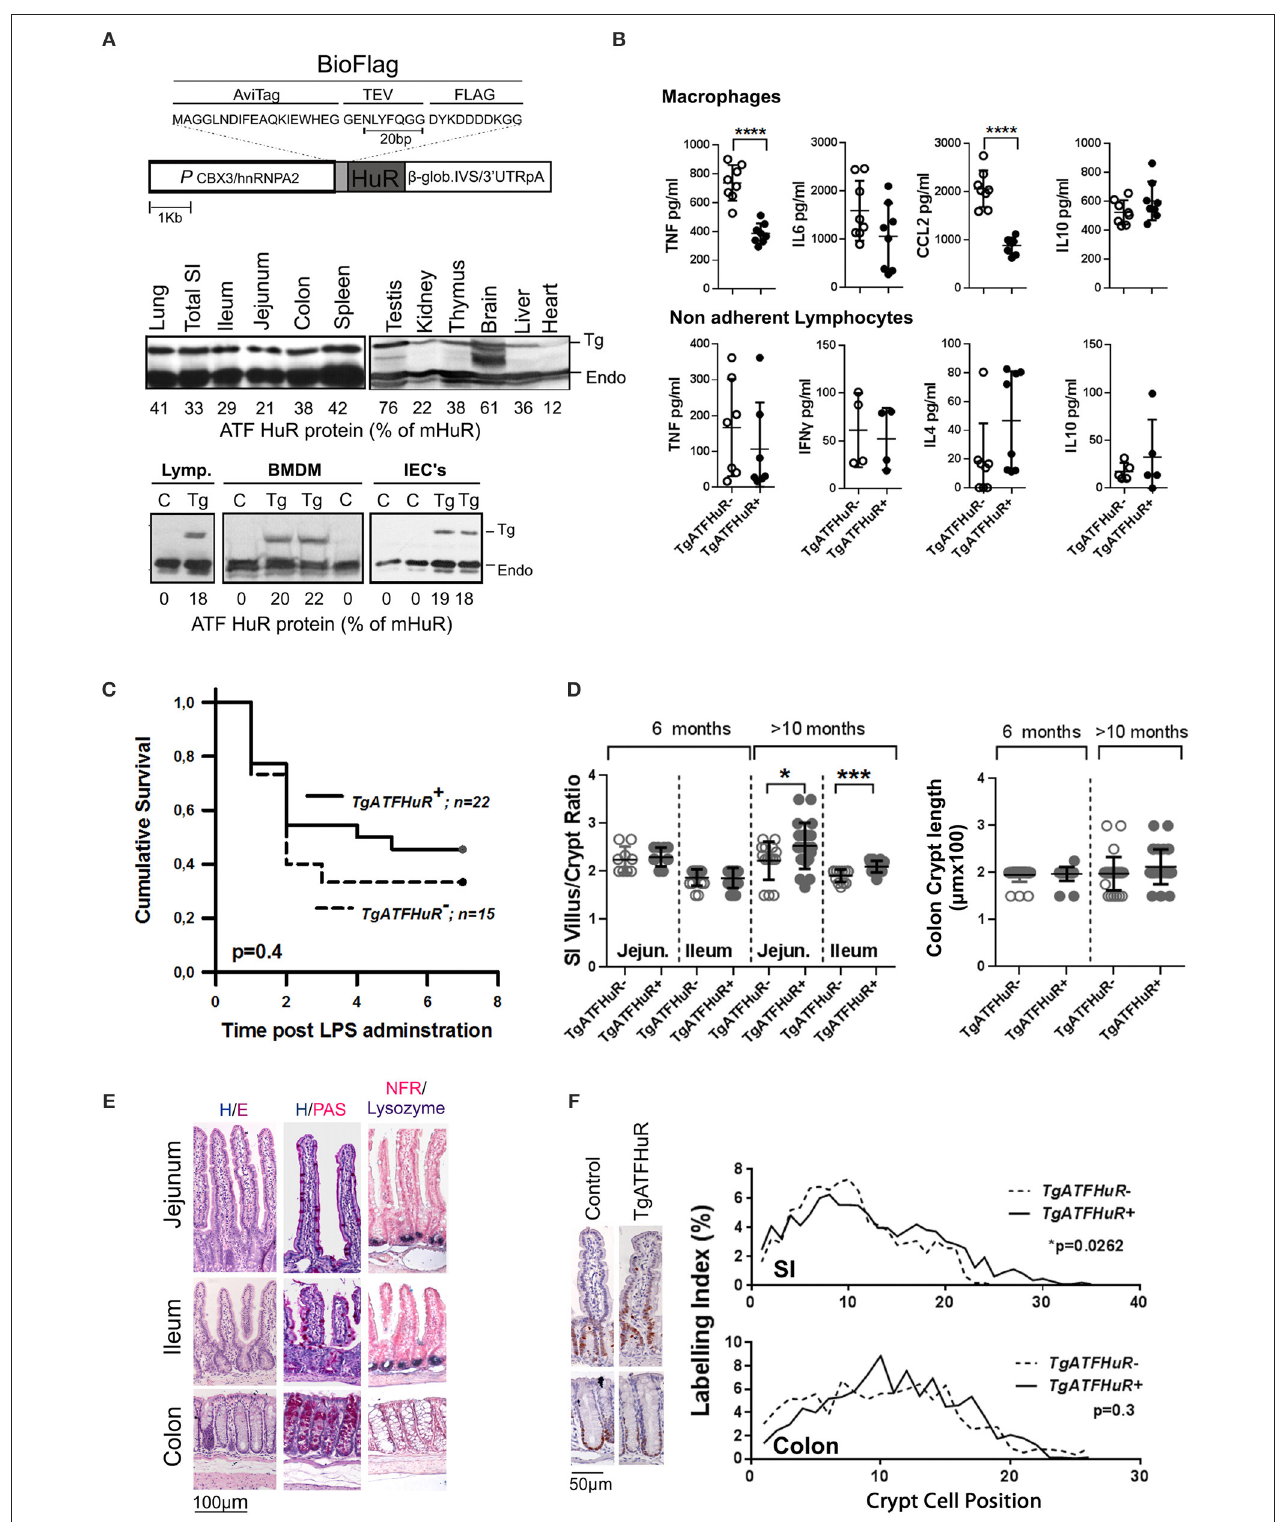
FIGURE 4 | Generation and characterization of HuR overexpressing TgATFHuR + mice. (A) (upper panel) Diagrammatic representation of the construct used for the generation of the TgATFHuR + mice indicating the presence of: the CBX3/hnRNPA2 promoter; the tagged version of the human HuR with aminoacid composition